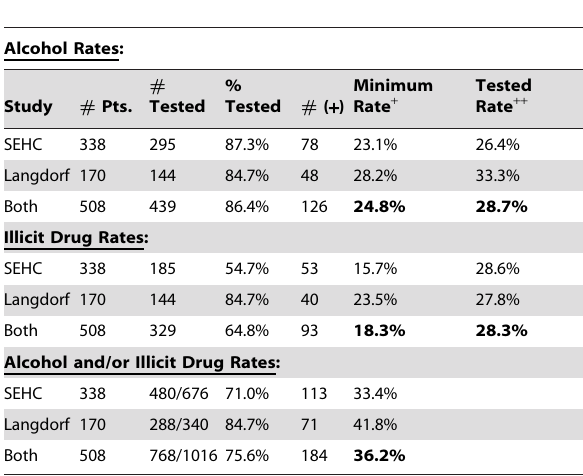
Table 1. SEHC Trauma Activation Patients traits and outcomes (n= 338).